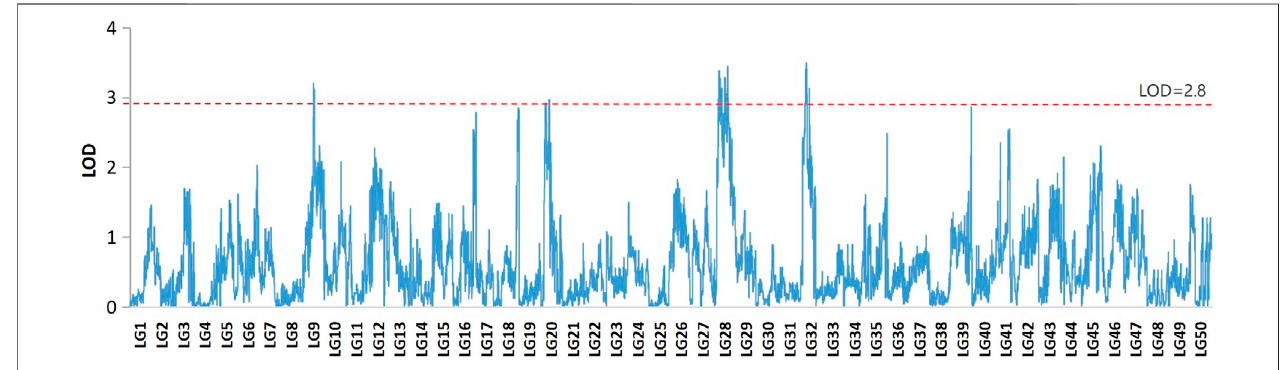
FIGURE 3 | QTL mapping and signi fi cant regions were identi fi ed for FCE in common carp.